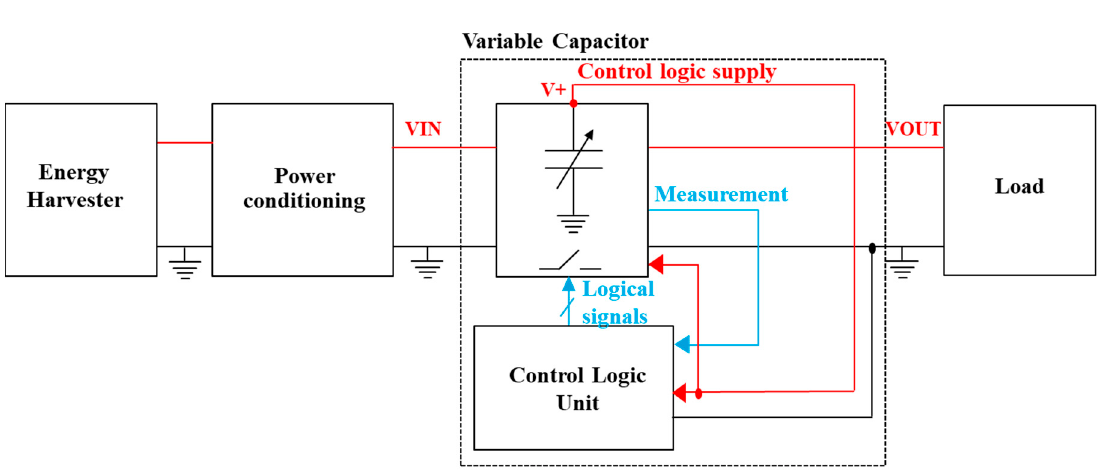
Figure 1. Block diagram of the proposed self-powered adaptive storage architecture (dashed-line block).